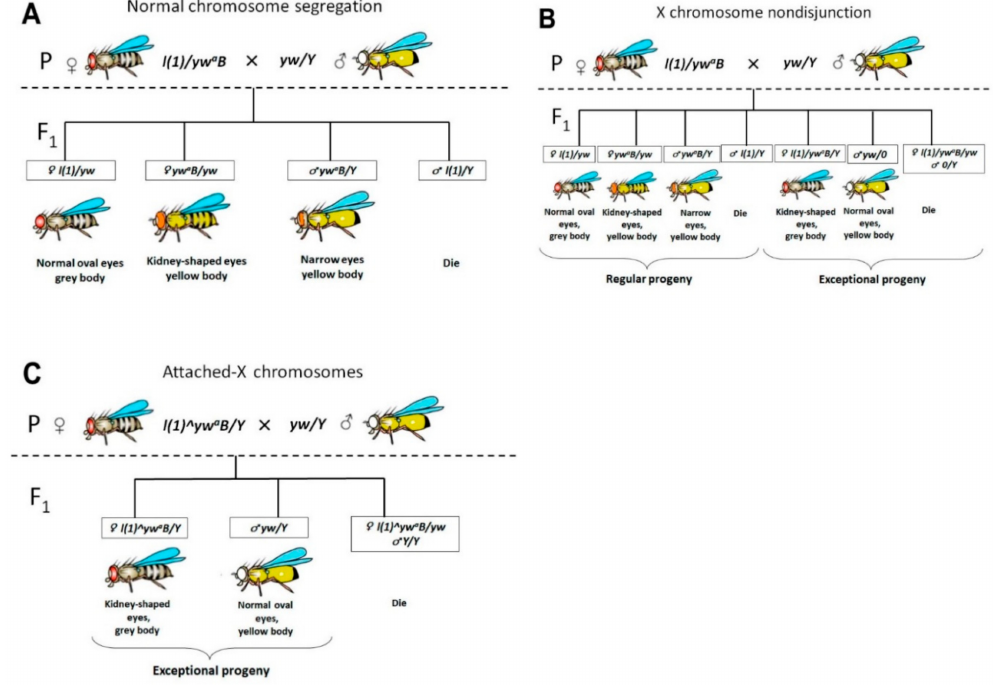
Figure 1. Schematic representation of individual genetic crosses for identifying females with attached-X and females with X chromosome nondisjunction. ( A ) Normal chromosome segregation; ( B ) F1 progeny from a female with X chromosome nondisjunction; ( C ) F1 progeny from female carrying attached-X. Phenotypic analysis revealed that in seven lines tested, two, ( l(1)G0425 and l(1)G0356 ), exhibited the presence of females with attached X (Table 1 and Table S1). Their male progeny had the expected patroclinous phenotype (“yellow